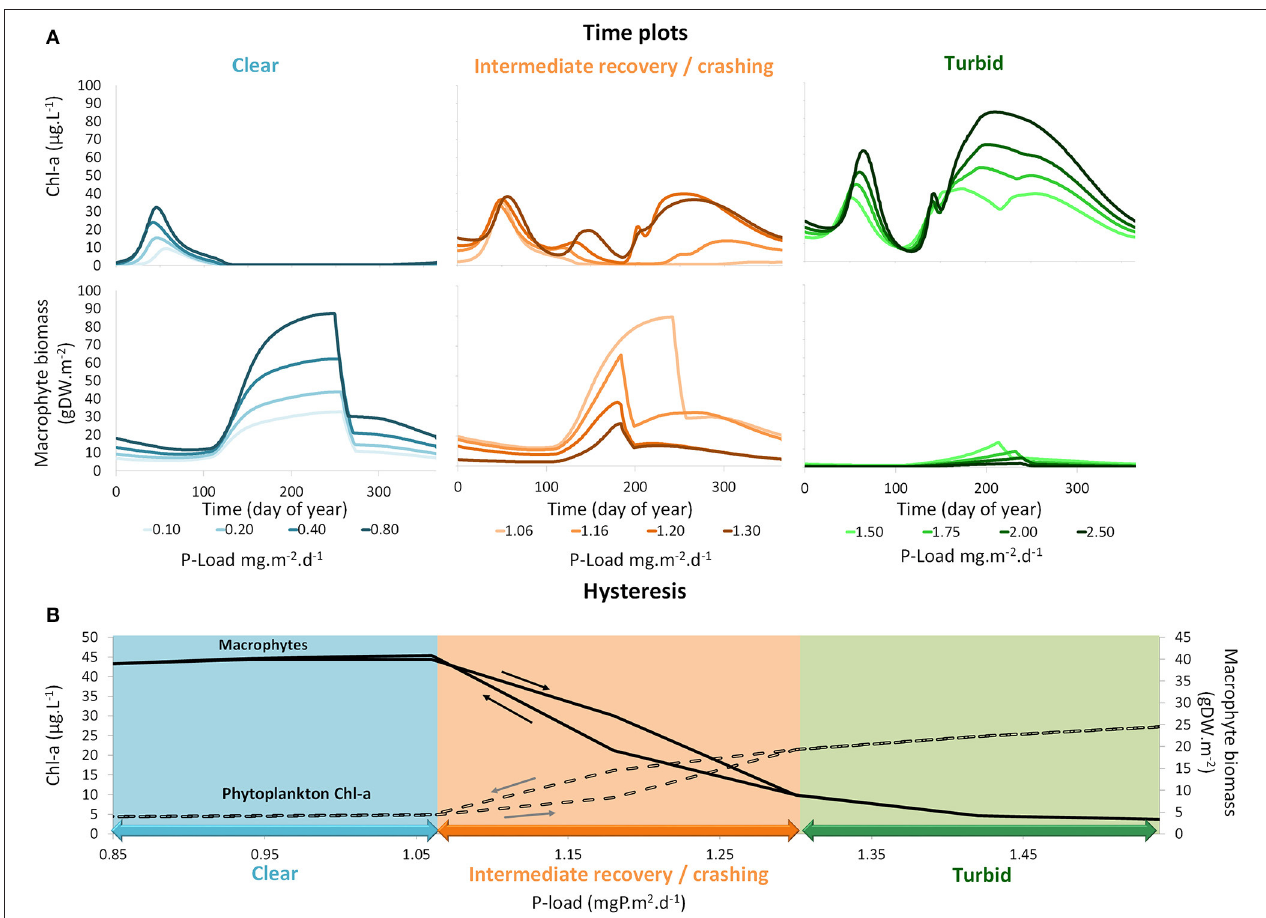
FIGURE 5 | (A) Time series of simulation using PCLake of chlorophyll- a concentrations and macrophyte shoot biomass for different phosphorus (P) loadings within the clear, intermediate recovery and turbid states. Darker colors are associated with higher P loading simulations. (B) Hysteresis plots showing yearly mean simulated values of chlorophyll- a concentrations and macrophyte shoot biomass for different phosphorus (P) loadings within the clear, intermediate recovery and turbid states. Arrows denote the directions of the hysteresis